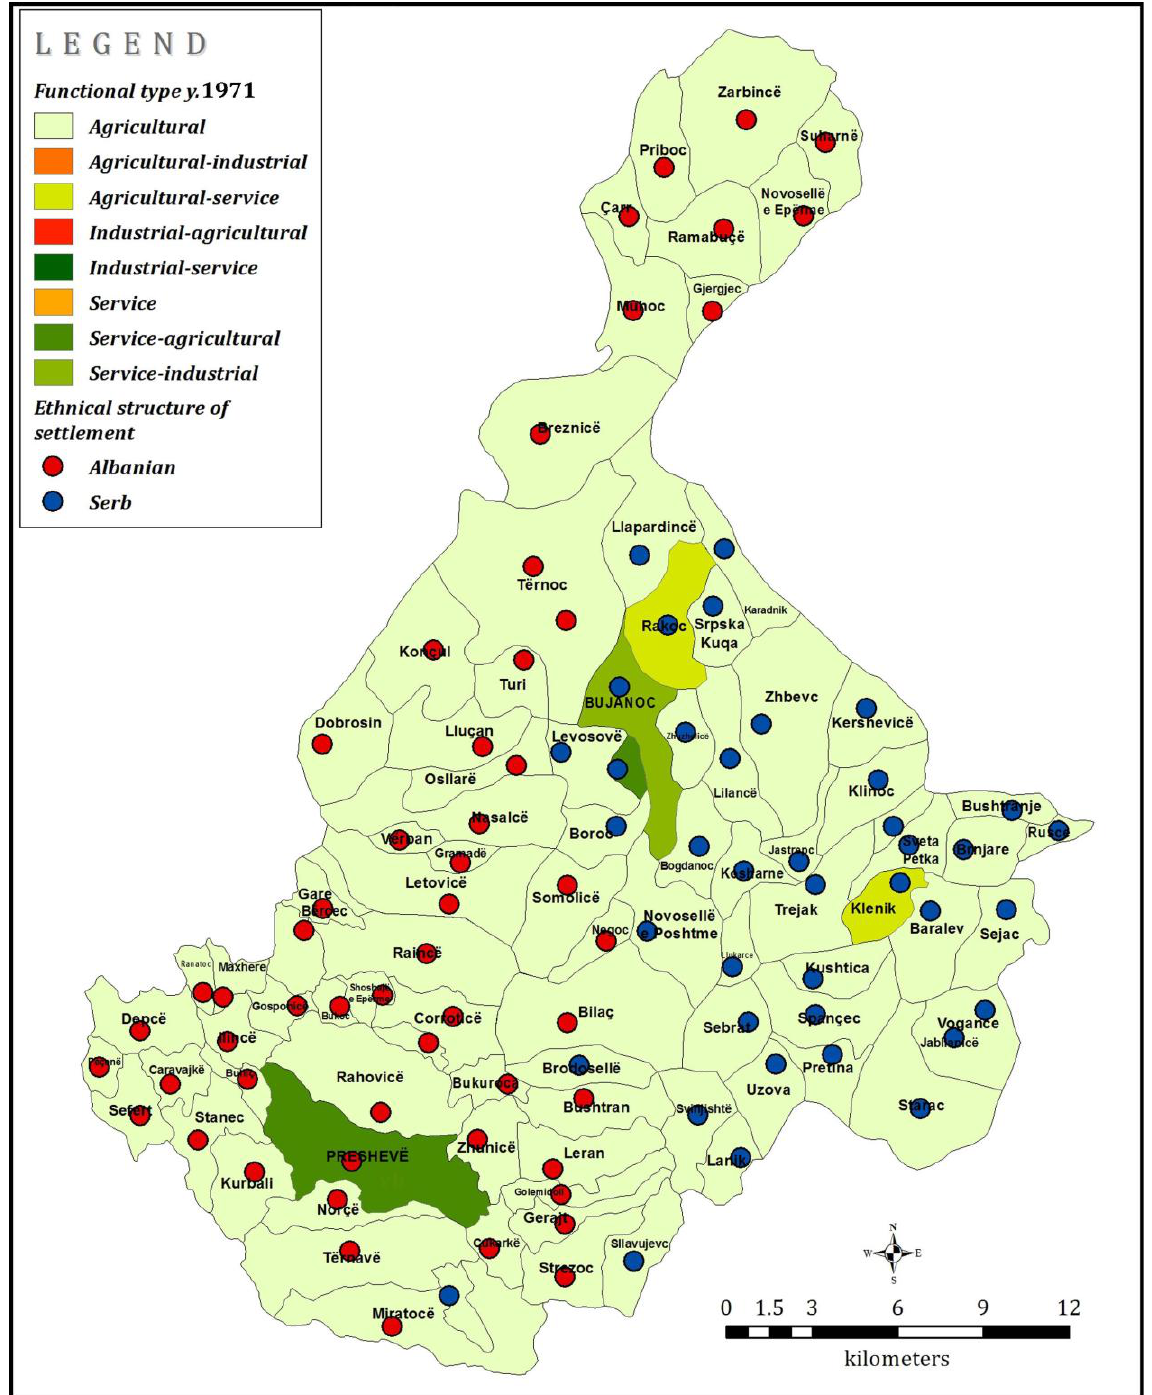
Fig. 3. Functional transformation of settlements in Presheva Valley (in